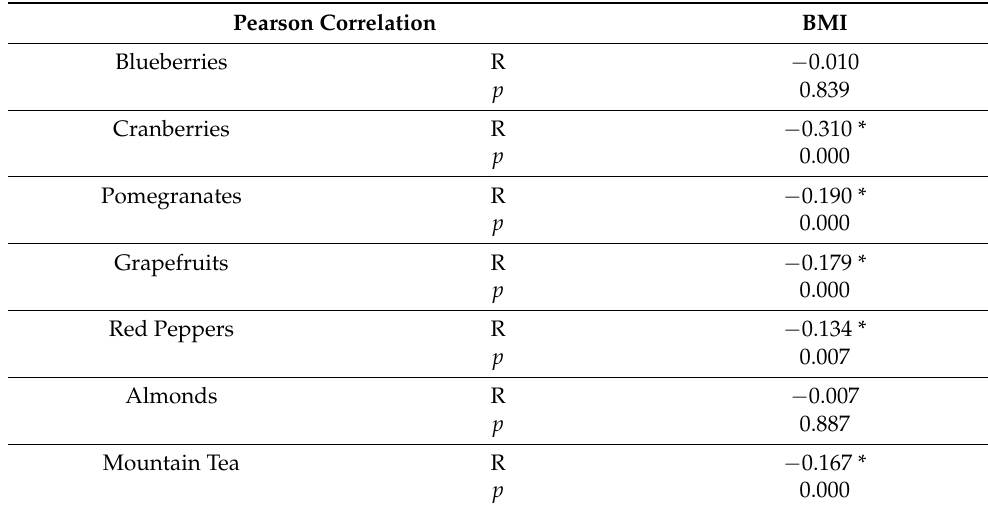
Table 4. Association of functional foods consumption with Body Mass Index (BMI) of the participants.